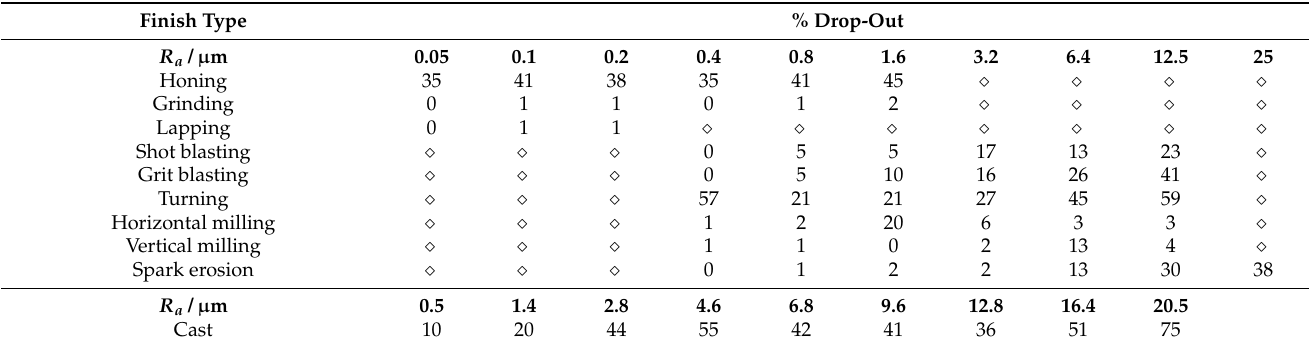
Table 4. Drop out for each roughness comparator, i.e., ratio of unmeasurable positions to measurable positions on the sample